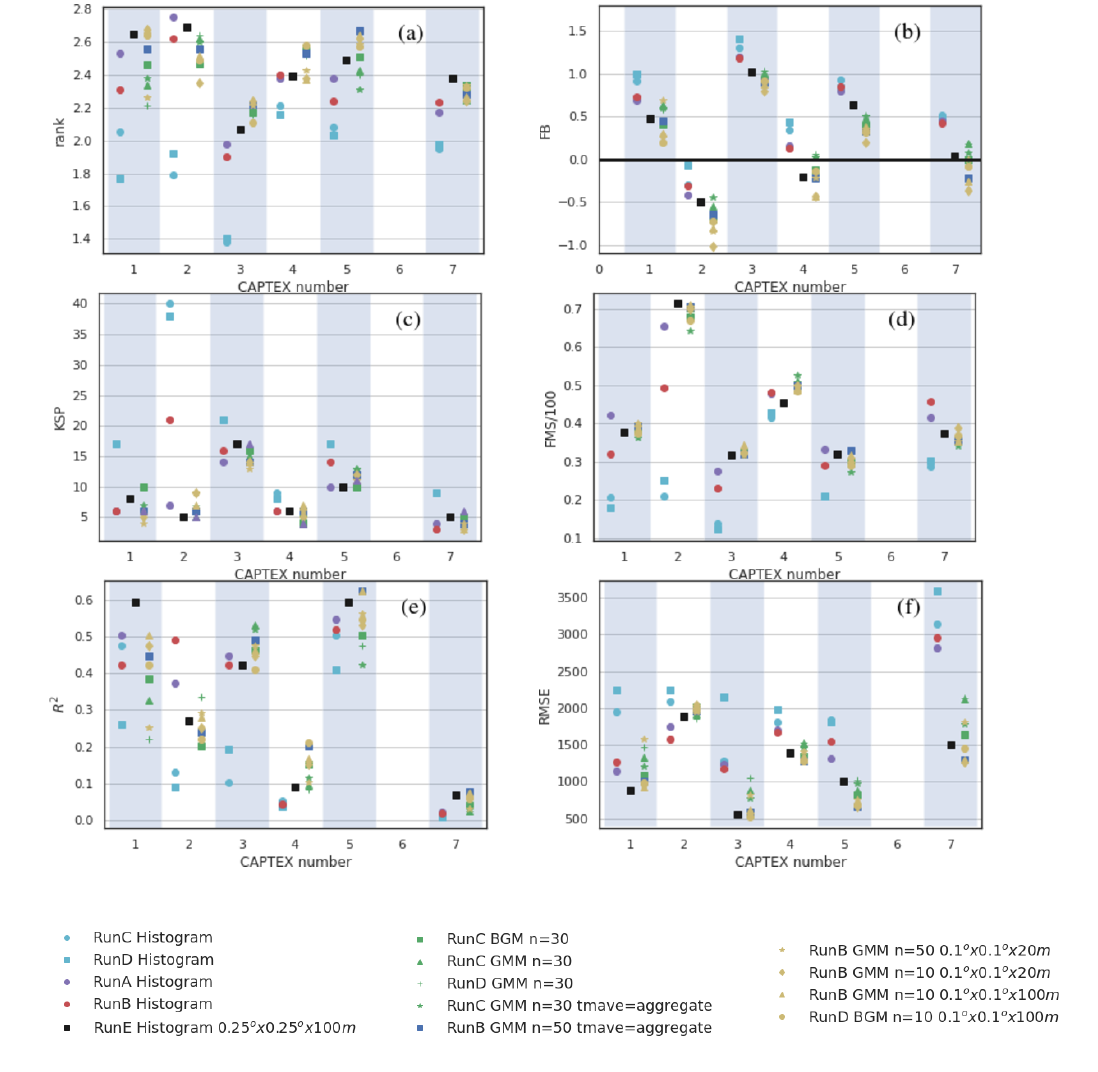
Figure 3. Statitics for CAPTEX experiments using a variety of density reconstructions. The rank, described by Equation (1) is shown in panel ( a ). The four statistics which go into calculating rank are shown in panels ( b – e ) and the root mean square error, RMSE, is shown in ( f ). Values for the standard simulation, runE, with standard concentration grid are shown by the black square. Values for concentrations calculated with the histogram and a high resolution grid are plotted slightly to the left of the black square. Values for concentrations calculated with the mixture model are plotted to the right of the black square. The high resolution grid of 0.05 ◦ × 0.05 ◦ × 25 m was used unless otherwise noted in the legend. For the GMM, the time averaging was performed with a separate fit to each output time unless tmave = aggregate is noted in the